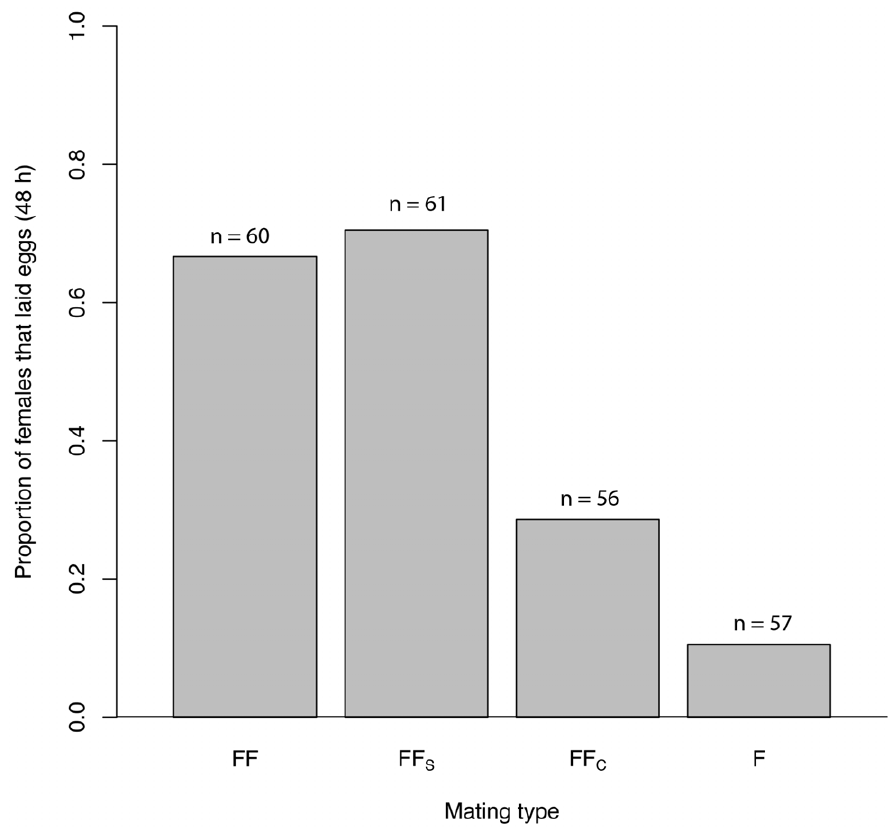
Figure 4. Proportion of G.firmus females that laid eggs within 48 h of mating. Females were mated with (1) a normal G. firmus male (FF), (2) a G. firmus male that underwent sham testes removal surgery (FF S ), (3) a G. firmus male surgically castrated (FF C ) or (4) remained unmated (F).